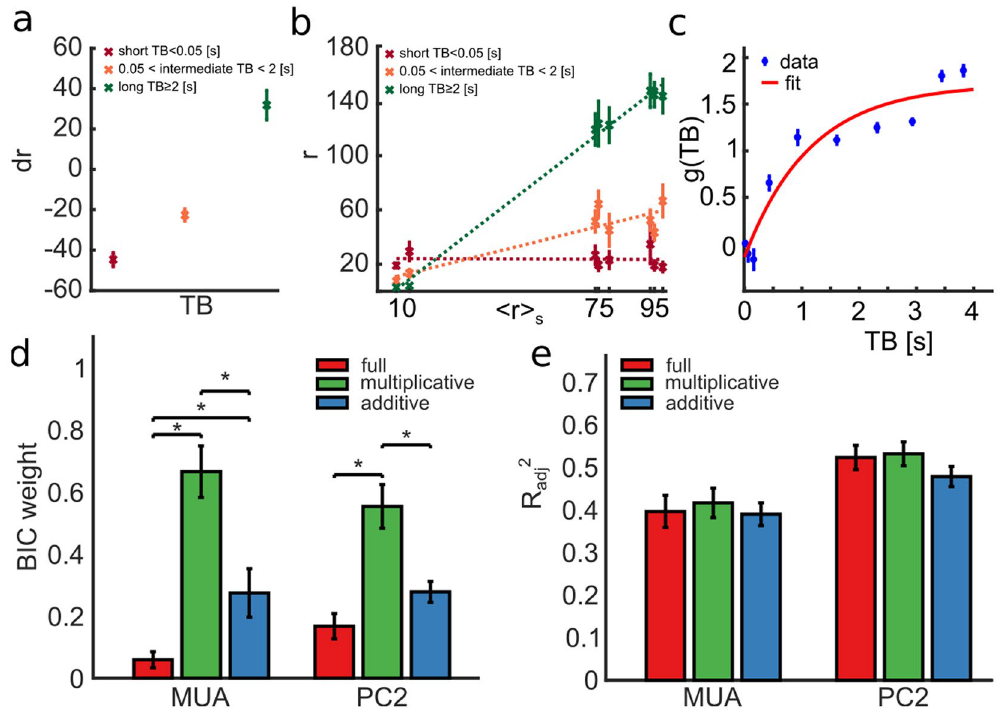
Figure 4. Single trial response r modeled as a linear combination of a stimulus-driven term and a noise term, both depending on state variable θ = TB. Panels A to C refer to the example recording session 208. All measures are computed in [0 100] ms time interval after stimulus. (a) Mean ± SEM across trials of trial-to-trial variability dr of MUA as a function of TB. State variable values are divided in three intervals: low TB if TB < 0.05 s , high TB if TB ≥ 2s, intermediate TB otherwise. dr depends linearly on TB (Pearson correlation = 0.97, p = 10 − 37 ). (b) Single trial response r depends linearly on the mean response at fixed stimulus 〈 r 〉 S with a slope g that depends on TB. Along the x-axis, MUA responses 〈 r 〉 S are ranked according to the corresponding stimulus. On the y-axis mean response r across trials and SEM are reported for long, intermediate and short TB (lines represent best linear fits). (c) MUA gain parameter g of the purely multiplicative model as a function of TB; data points show mean and SEM of g ( TB ) for TB binned in 10 equi-populated intervals; red line shows bi-exponential fit to the data points. (d) Mean ± SEM across all experiments of BIC weights for, respectively, full model (red bars), purely multiplicative model (green bars) and purely additive model (blue bars). The BIC weight of the purely multiplicative model is significantly higher (1-way ANOVA followed by Tukey’s HSD multiple comparison test) than BIC weights estimated in other models when considering both MUA (F(2, 297) = 83.45, p = 10 − 29 ) and PC2 (F(2, 297) = 23.82, p = 10 − 10 ) as response features. (e) Mean and SEM across all experiments of the coefficients of determination R 2 adj between responses R and R model adjusted for the number of parameters used in the model is reported for MUA and PC2 response representations. For most of the response representations, the coefficient of determination is higher for the purely multiplicative model than for the full or purely additive 2 of different models are not significantly different (1-way ANOVA, p = 0.2) for model, although the means R adj the evaluated response